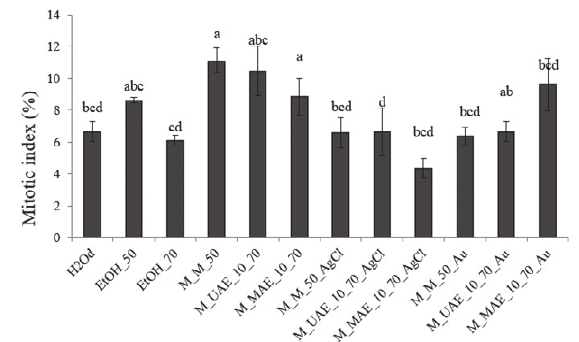
Figure 10. MI (%) of simple extracts of M. officinalis and nano- structured phytochemical complexes (a–d: interpretation of the sig- nificance of the differences, by means of the Duncan test, p <